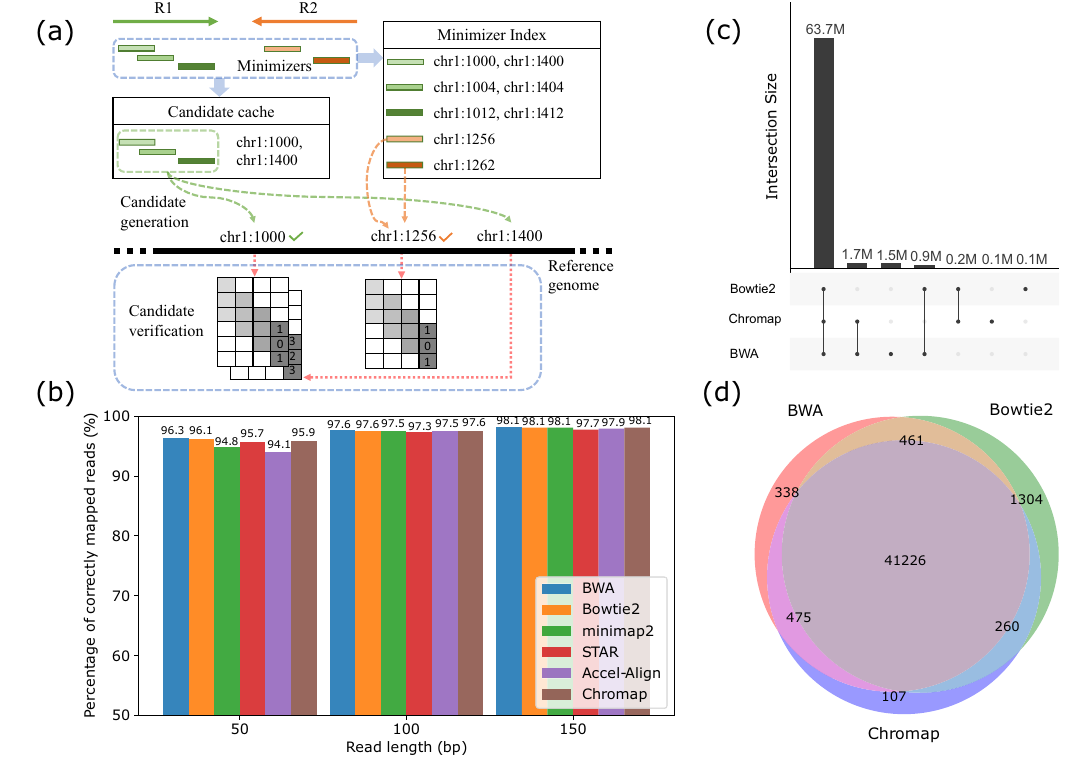
Fig. 1 Overview of Chromap. a Work fl ow of Chromap mapping a read-pair R1 and R2. First, their minimizers are extracted and then queried in the candidate cache and the minimizer index. The set of three minimizers of R1 is in the cache and the candidate mapping start positions are returned by the cache. The set of two minimizers in R2 is not in cache. So each of them is searched in the minimizer index and the occurrences of the minimizers are used to derive the candidate mapping positions. Then all the candidates are veri fi ed, which results in the fi nal mapping. b Accuracy of methods on the simulated data with different read lengths. c Consensus of read alignments from Chromap, BWA-MEM, and Bowtie2 on bulk ChIP-seq data. d Overlapped peaks called from the alignments reported by different methods on bulk ChIP-seq